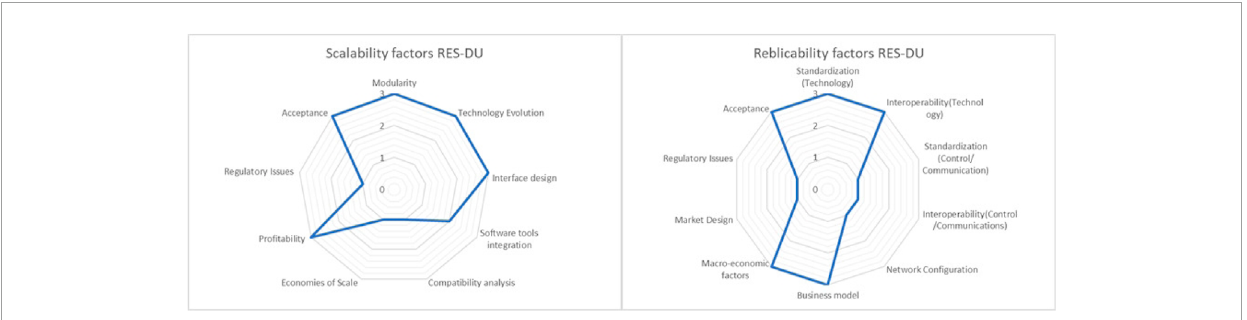
FIGURE 4 Spider graph on RES-DU scalability and replicability assessments.